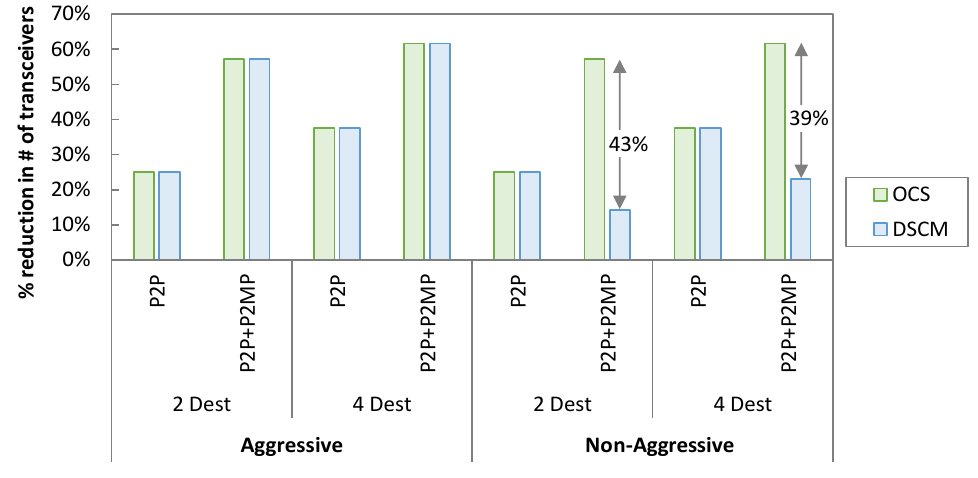
Figure 10. Reduction in number of transceivers.